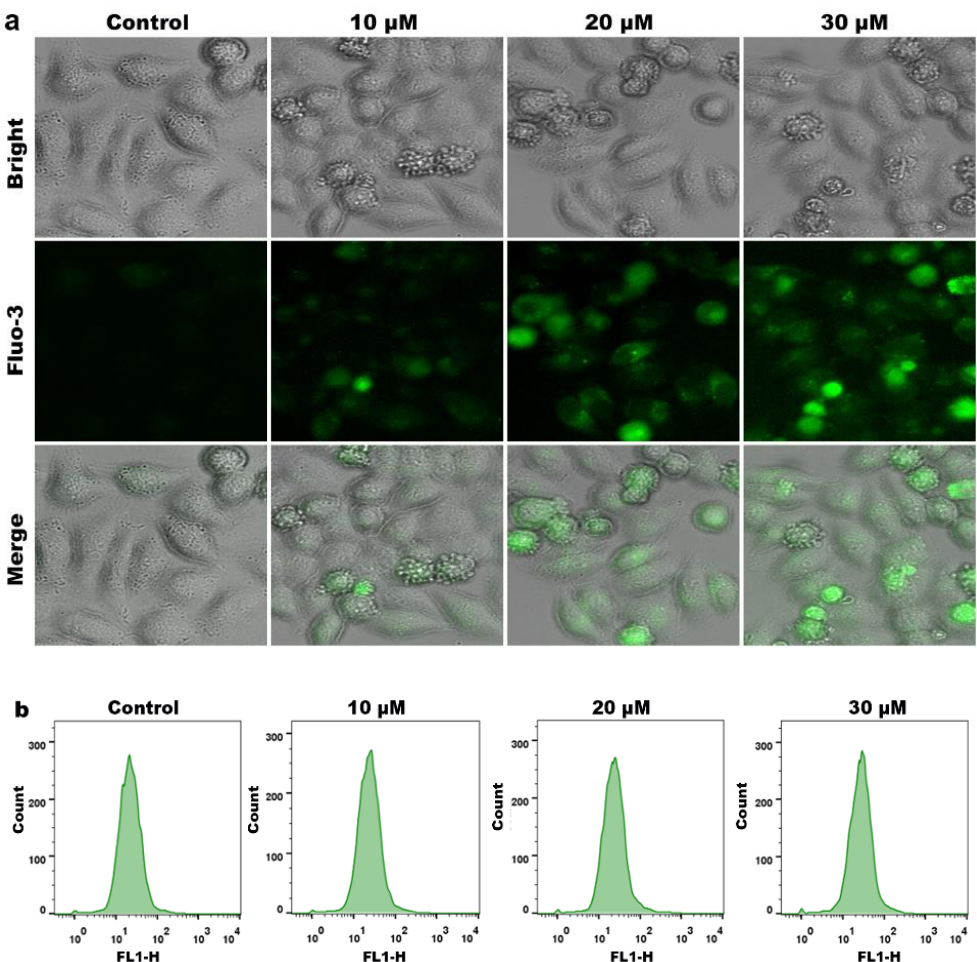
Figure 6. ( a ) Intracellular Ca 2+ levels were assayed after HeLa cells were exposed to different concentration of 3a for 24 h. ( b ) Quantification of intracellular Ca 2+ levels.